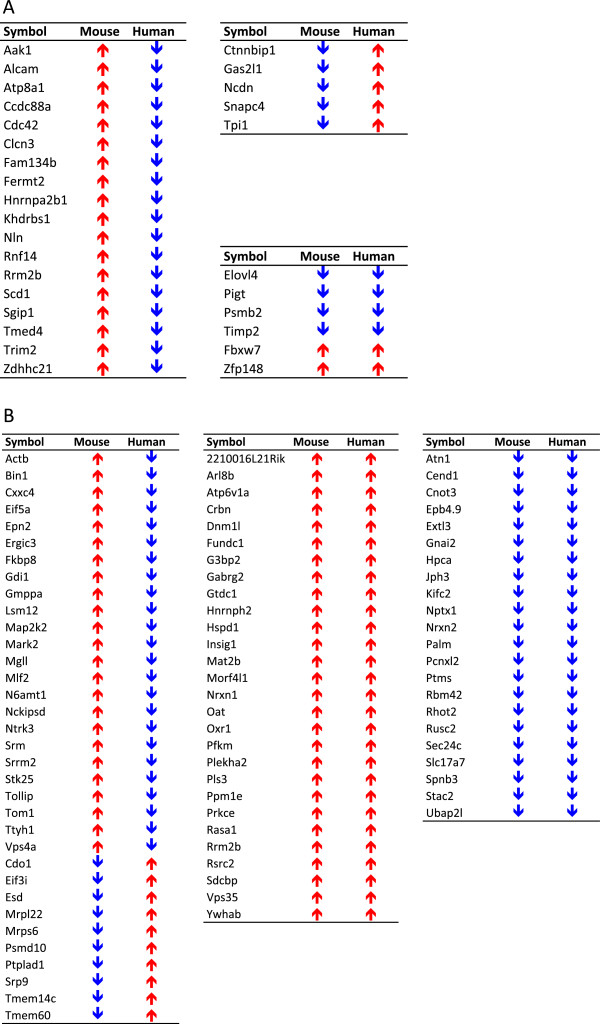
Conserved differential gene expression in response to ethanol with implicit model differences in direction of change. A: Venn diagram highlights common set of 29 differentially expressed genes in prefrontal cortex of human alcoholics (as reported by [14]) and ethanol-treated mice (current results); B: Directionality of expression changes in common set of 29 differentially expressed genes referred to in A; C: Venn diagram highlights common set of 84 differentially expressed genes in prefrontal cortex of human alcoholics (as reported by [15]) and ethanol-treated mice (current study); D: Directionality of expression change in common set of 84 differentially expressed genes referred to in C. P values empirically assessed after 105 and 107 Monte Carlo simulations, respectively.